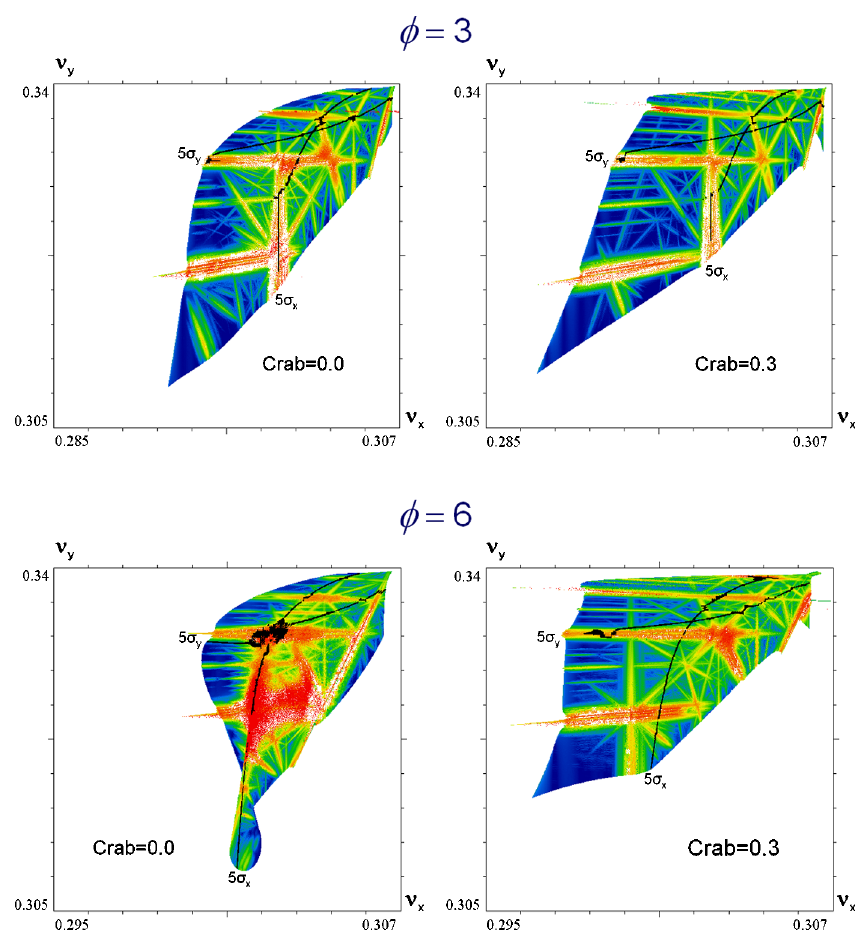
FIG. 15. Efficiency of CW versus the Piwinski angle for (cid:6) x =(cid:6) y ¼ 2